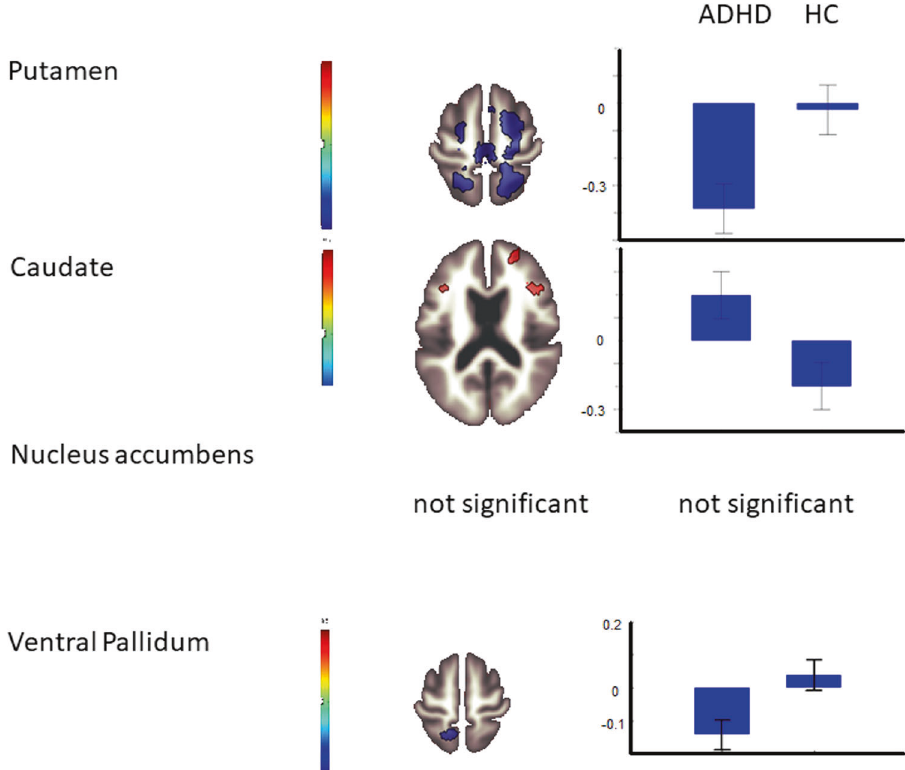
Fig. 1 Connectivity in ADHD > HC. The left column gives the name of the seed region-of-interest. The middle column titled shows an exemplary brain slice depicting a signi fi cant brain cluster. Color is given in the color bar which codes effect size in red or blue. The column on the right gives mean extracted beta-values for the respective comparison between ADHD and HC to demonstrate absolute values and direction of the effect. ADHD attention-de fi cit hyperactivity disorder, HC healthy